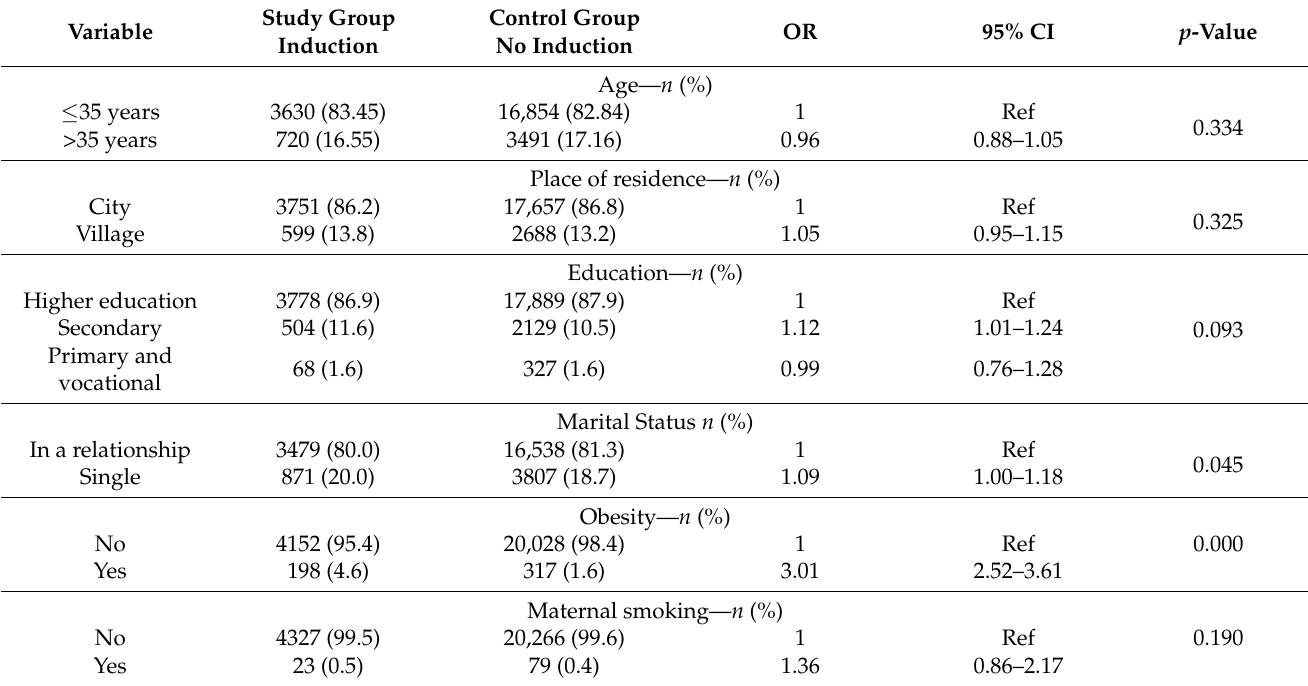
Table 1. Characteristic of the